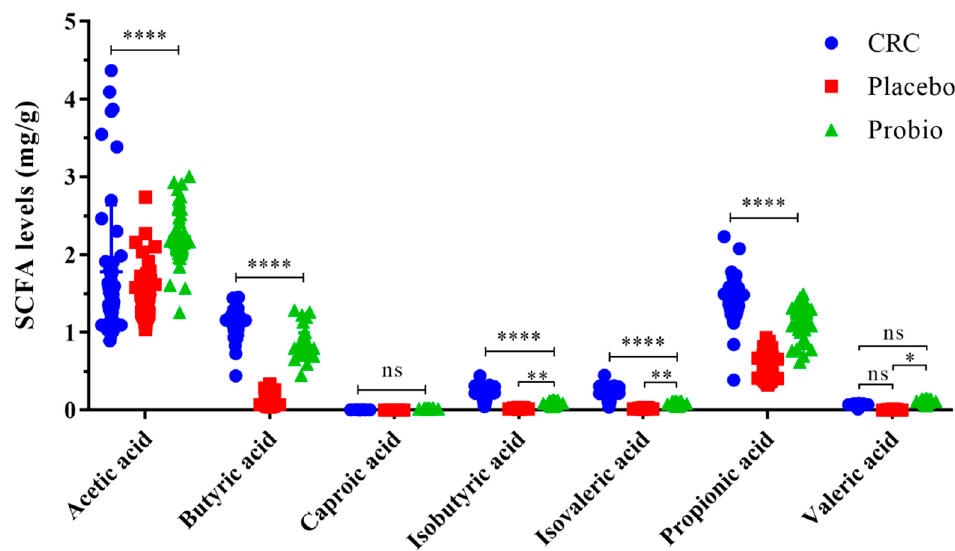
Figure 5. Probiotics combination promoted the production of SCFAs in the gut of CRC patients undergoing chemotherapy. CRC, the standard reference group before anticancer treatment. Placebo, the control group taking placebo. Probio, the treatment group taking probiotics combination. Multiple comparisons based on two-way ANOVA analysis following Tukey’s test, * p < 0.05, ** p < 0.01, **** p < 0.0001; ns refers to no significant difference detected. The capped line refers to comparison among the three groups; the half tick-down line refers to comparison between the two groups.